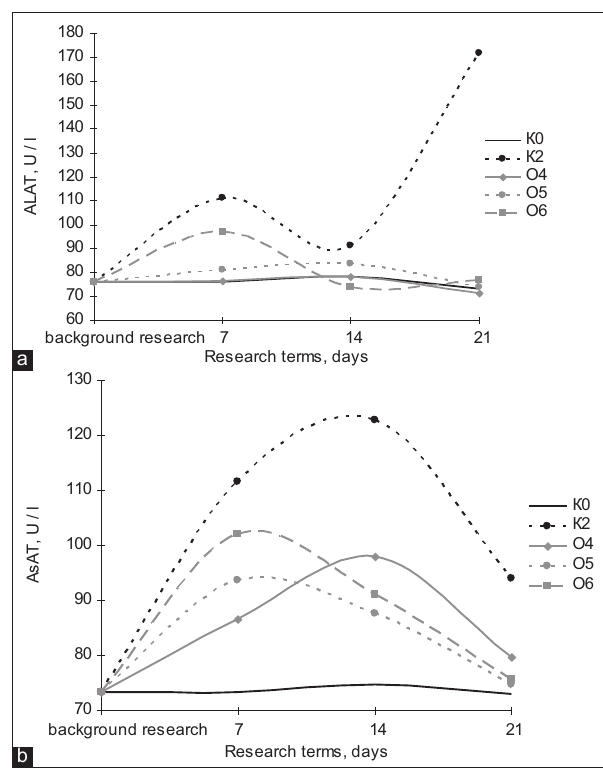
Figure-6: Dynamics of changes in the concentration of (a) ALT and (b) AST in laboratory animals: К К – control of the metal (Cu), О 2